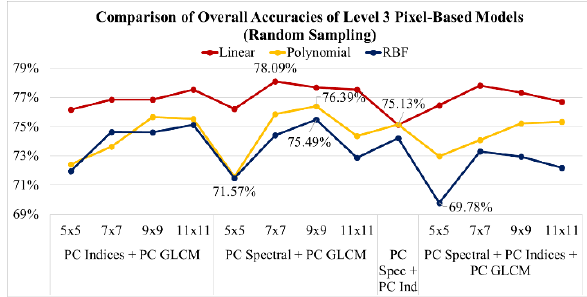
Figure 13: Overall accuracies of the Level 3 random models In terms of the median kappa index per kernel type, the linear models obtained the highest median kappa index of 0.5857. the polynomial and RBF classifiers attained scores of 0.5503 and 0.5130, respectively. All of them translate to moderate strength of agreement, based on the scale of Landis and Koch (1977). Similarly, the linear model got the highest median overall accuracy, followed by polynomial, and lastly, RBF.